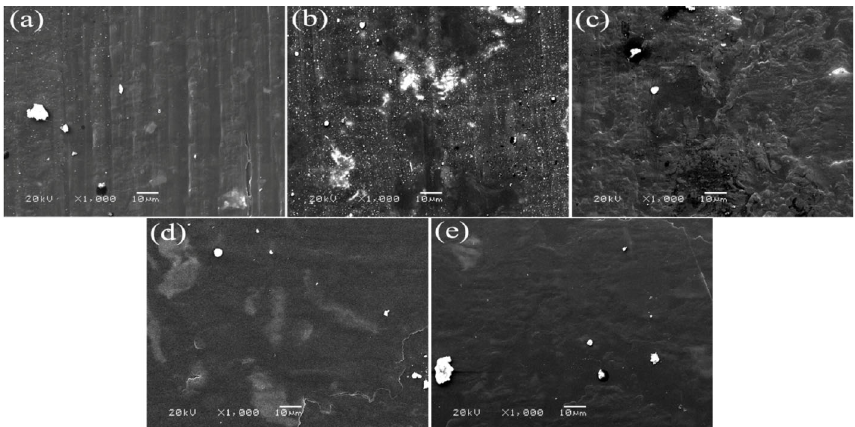
Fig. 10 SEM images of the worn surfaces of the (a) pristine, (b) MWCNT filled, (c) MoS 2 reinforced, (d) MoS 2 -MWCNT-1 reinforced and (e) MoS 2 -MWCNT-2 reinforced polyurethane composite coatings.